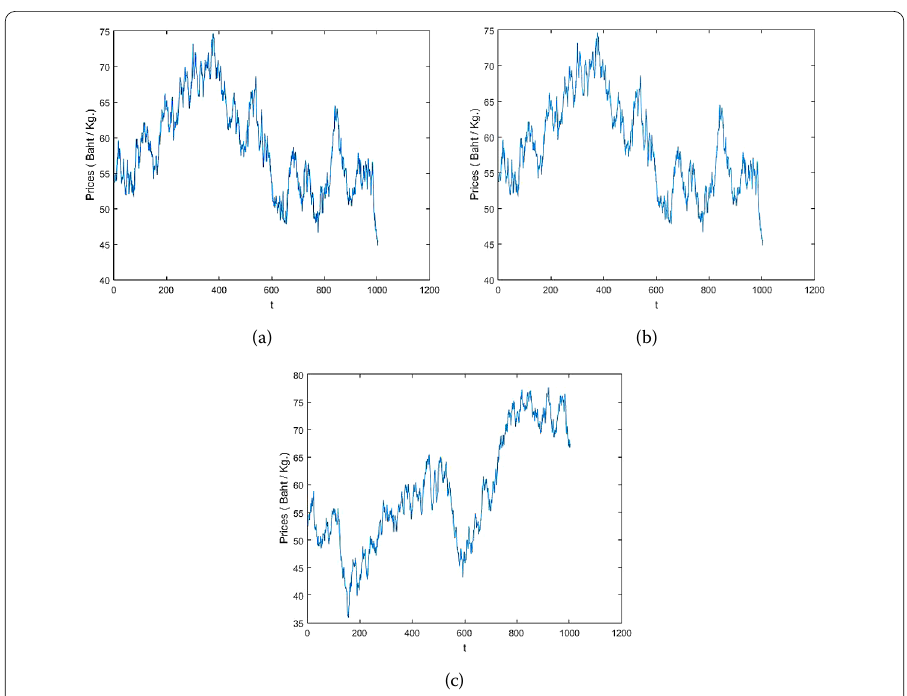
Figure 5 Results of simulation with Ornstein-Uhlenbeck process of RSS3: (a) Results of simulation with Ornstein-Uhlenbeck process of RSS3 with least squares regression λ = 0.7434. (b) Results of simulation with Ornstein-Uhlenbeck process of RSS3 with maximum likelihood estimation λ = 0.7434. (c) Results of simulation with Ornstein-Uhlenbeck process of RSS3 with jackknife technique λ = 0.5772.